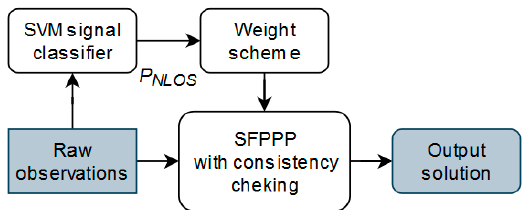
Figure 2. The architecture of the SVM based weight scheme based SFPPP system.